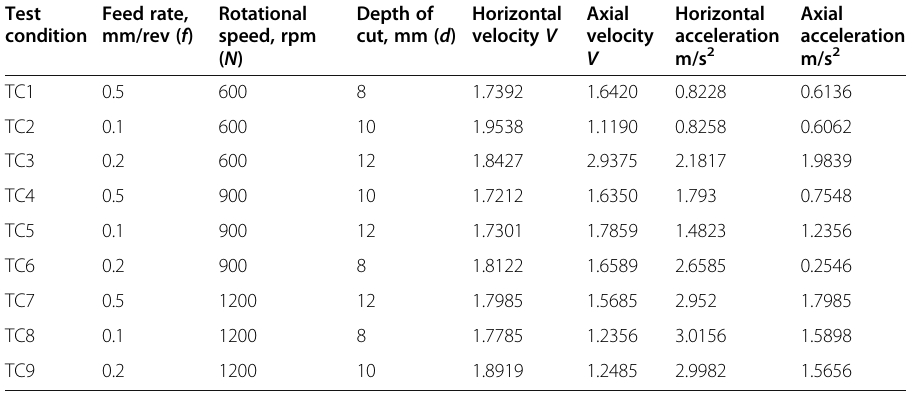
Table 3 Vibrational data of tool A Test Feed rate, condition mm/rev ( f )